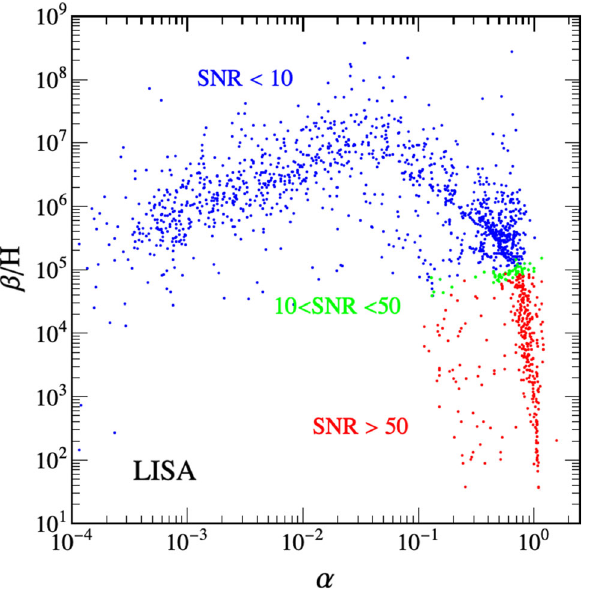
Fig. 3 The SNRs at the near-future detector LISA with the blue points for SNR < 10, the green points for 10 < SNR < 50 and the red points for SNR > 50. The data-taking duration is adopted as 4